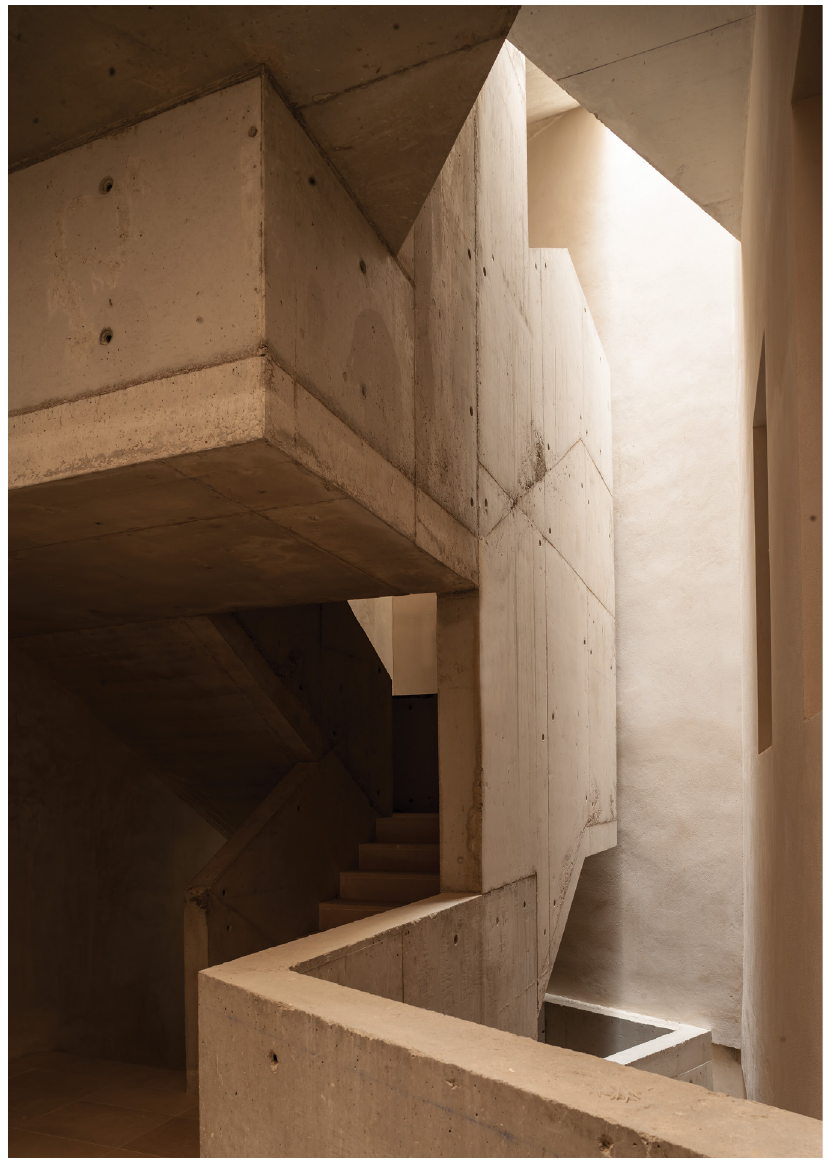
Figure 6. Flores Prats. Casal Balaguer (2009– ). View into new circulation, balconies and light well. Photograph Adrià